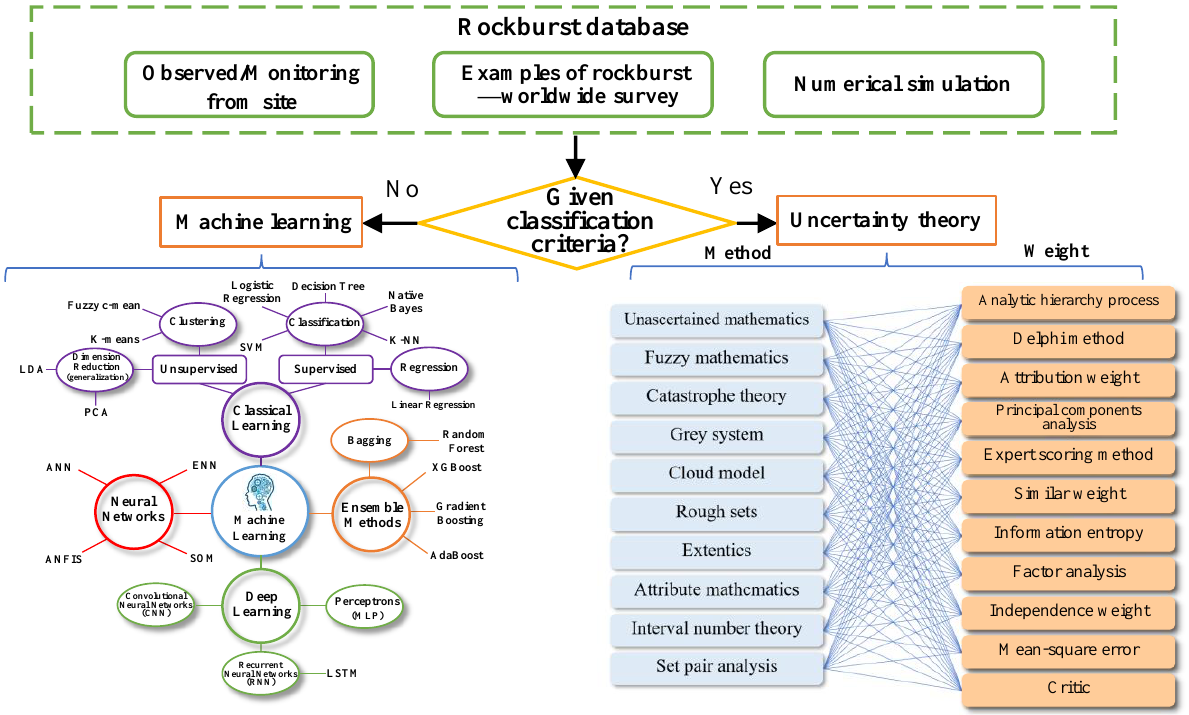
Figure 6. Mathematical model approaches of rockburst classification and prediction.